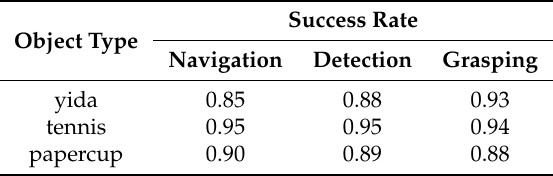
Figure 15. The process of autonomous mobile manipulation. ( a ) Robot initiating. ( b , c ) Navigating to the target area. ( d , e ) High-precision localization based on laser reflectors. ( f ) Detecting the desk. ( g ) Detecting the object. ( h ) Grasping. Table 4. Mobile manipulation success rate for different objects (total =